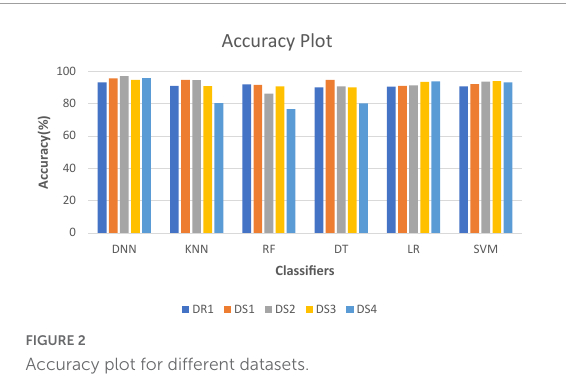
FIGURE2 Accuracy plot for different